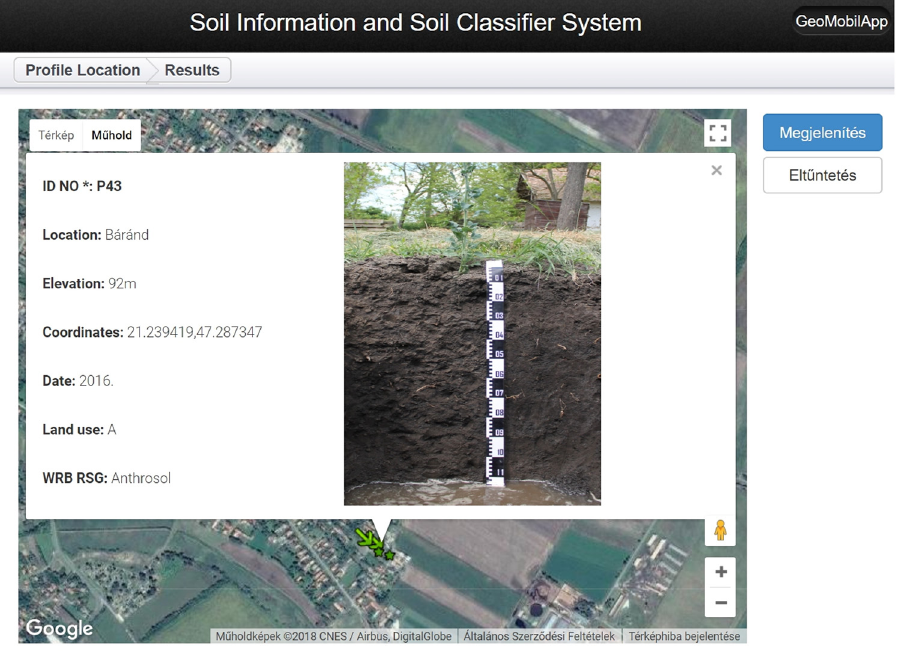
Figure 9: Geovisualized soil pro fi le with the selected data from the database ( source of photo of soil pro fi le photo: Mester et al. 2017 )